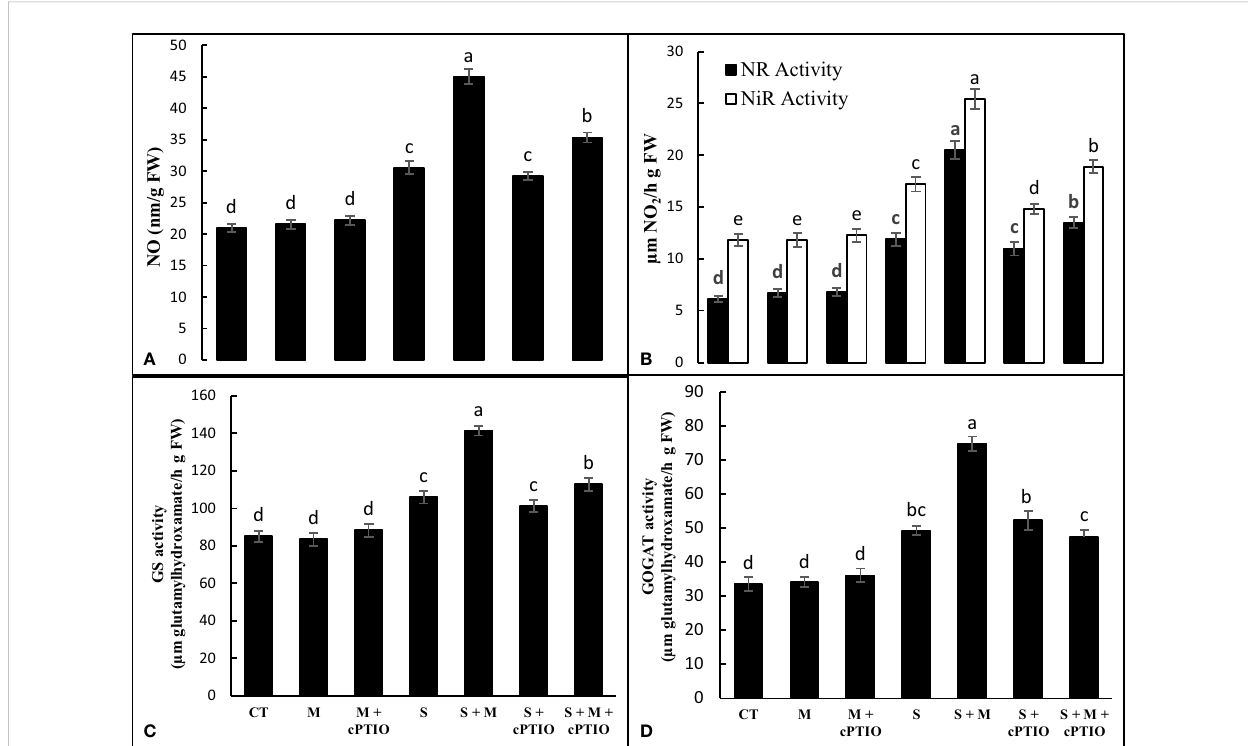
FIGURE 4 The leaf content of nitric oxide (NO, A ) and the leaf activities of nitrate reductase (NR, B ), nitrite reductase (NiR, B ), glutamine synthetase (GS, C ), and glutamyl synthetase (GOGAT, D ) enzymes in tomato seedlings treated with melatonin (150 m M) and cPTIO (100 m M) under NaCl (150 mM) treatment. Different letters in each column show signi fi cant differences at the p < 0.05 based on the LSD test (means ± SD, n = 5), CT, control treatment; M, melatonin; S, salinity.